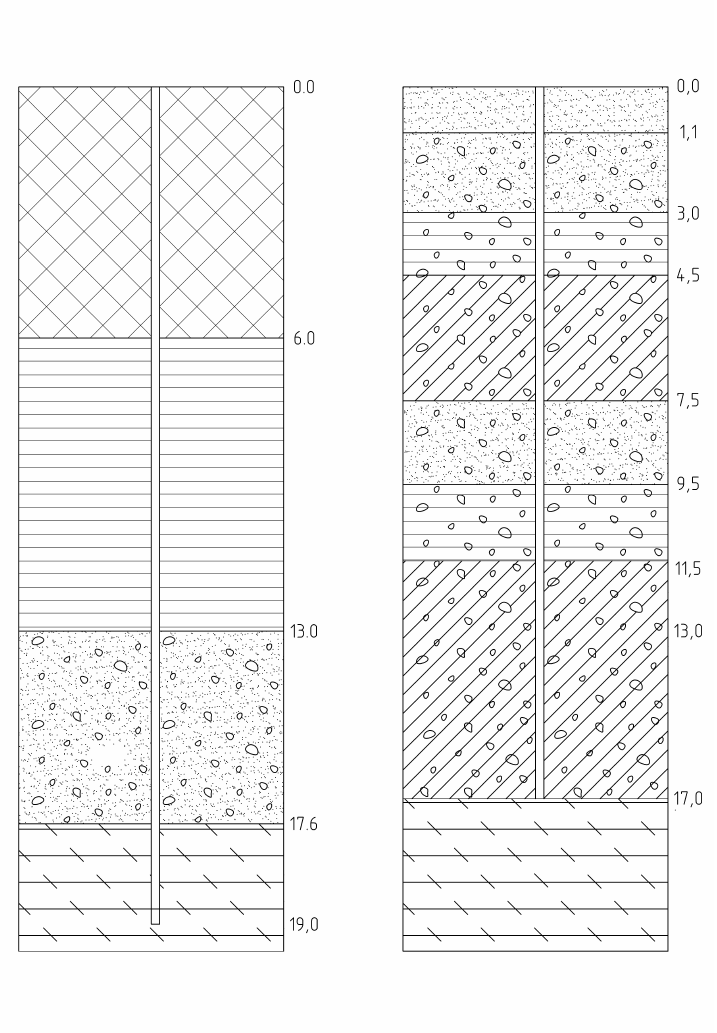
Figure 1. Geological section of experimental